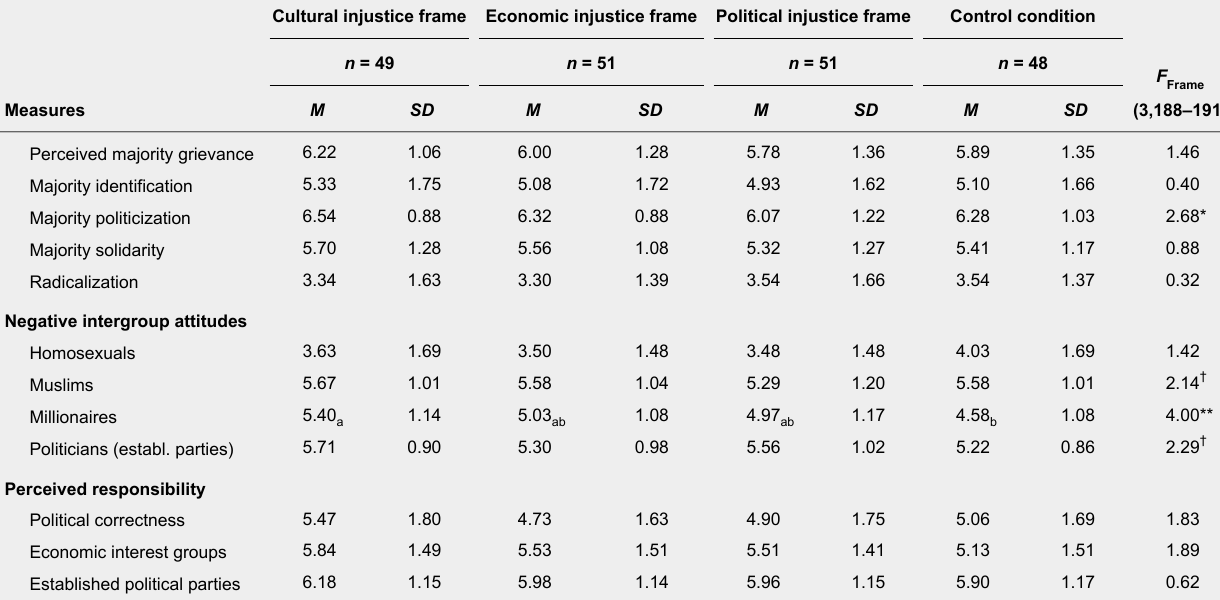
Means and Standard Deviations for the Dependent Measures (Experiment 2)